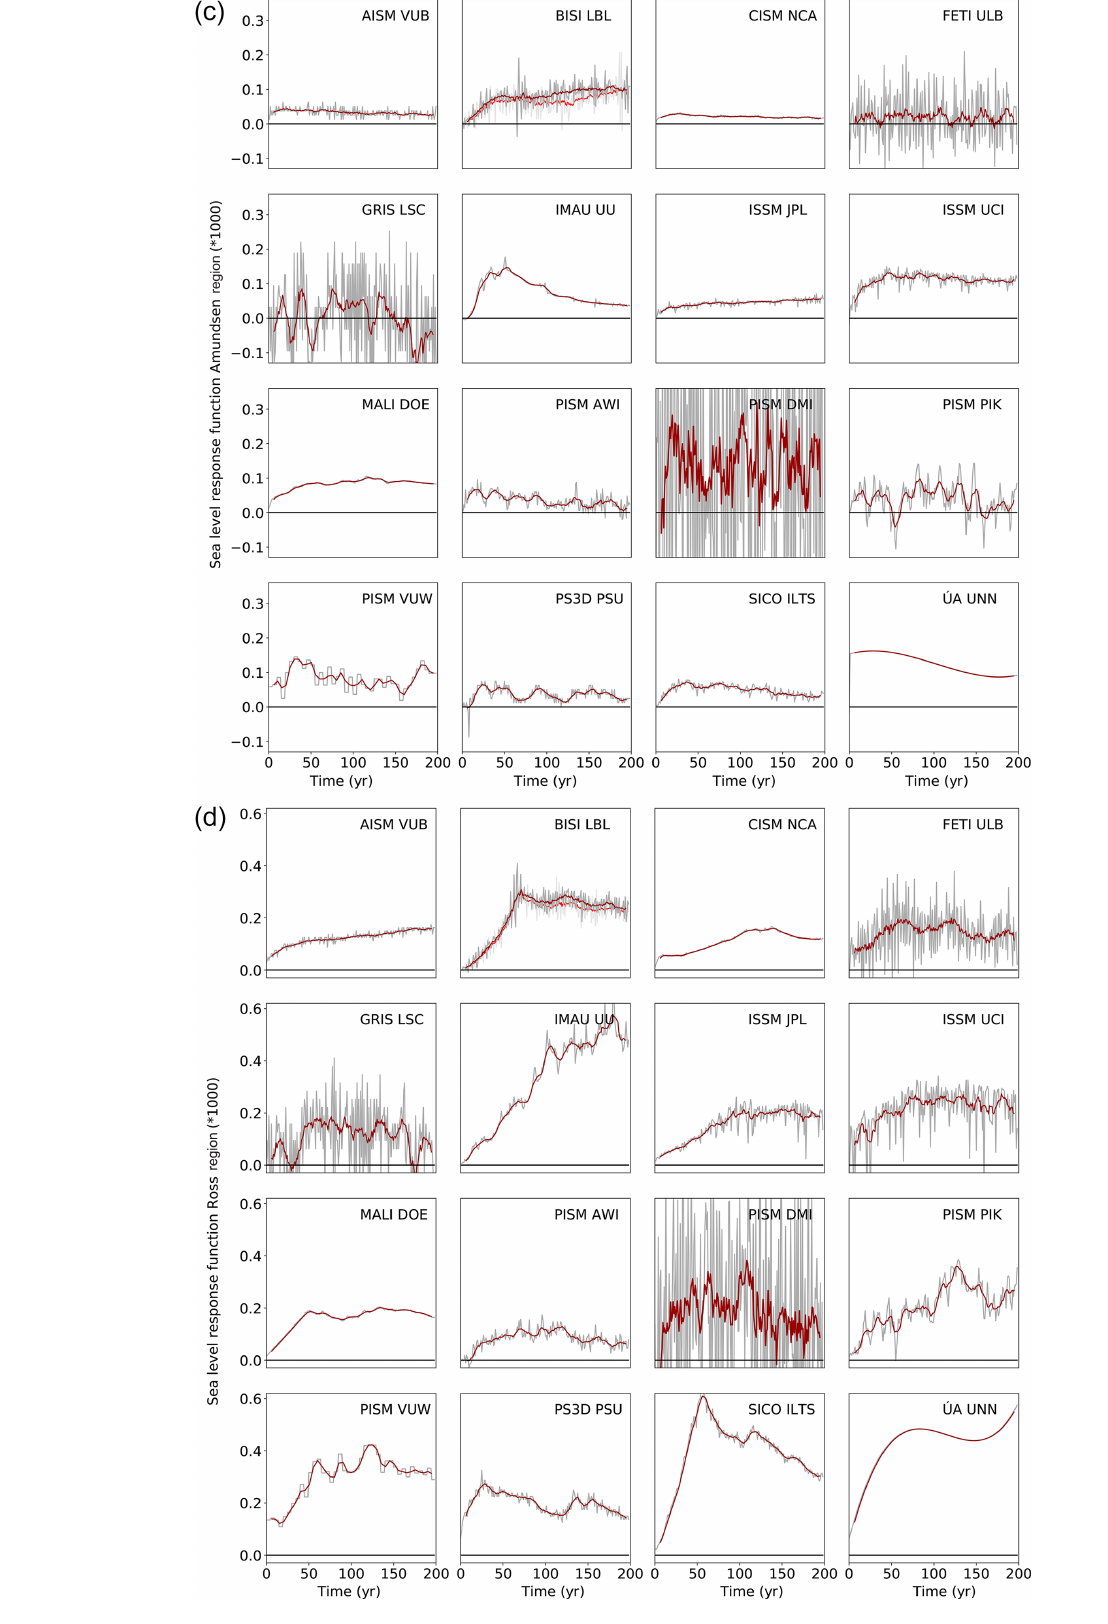
Earth Syst. Dynam., 11, 35–76,